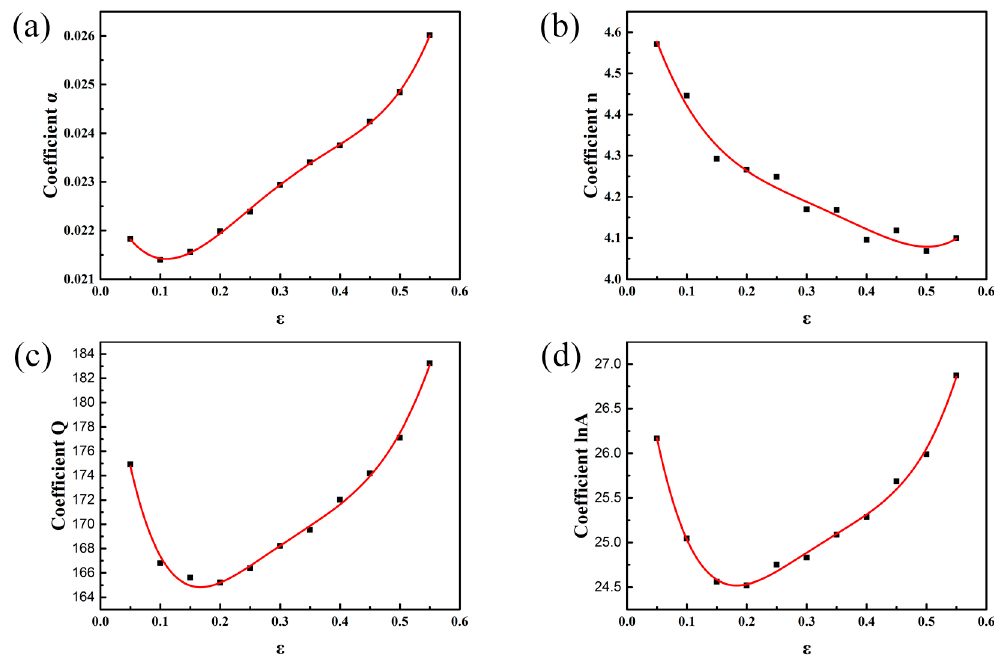
Figure 4. Relationship between strain and material constants of ( a ) α ; ( b ) n; ( c ) Q ; and ( d ) lnA. Table 1. Coefficients of polynomial fitting curves for material coefficients.